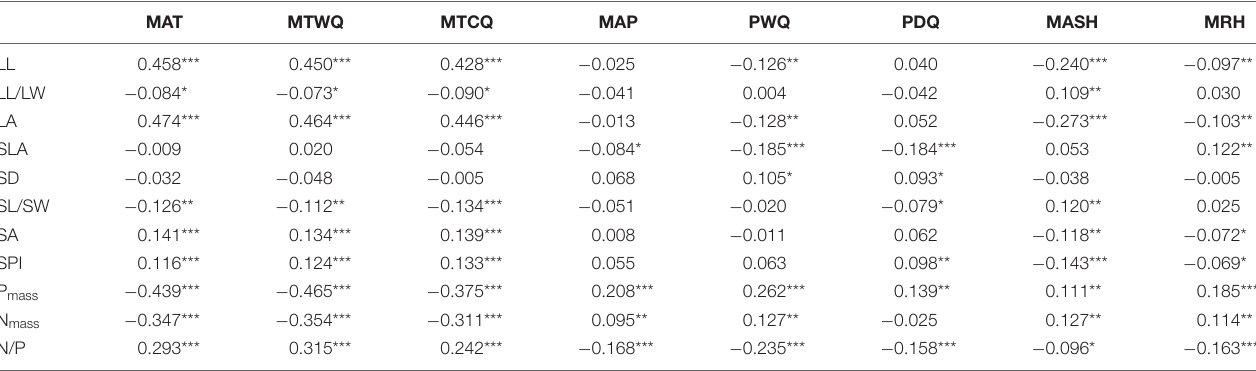
TABLE 2 | Results of the linear relationship between leaf traits and climate